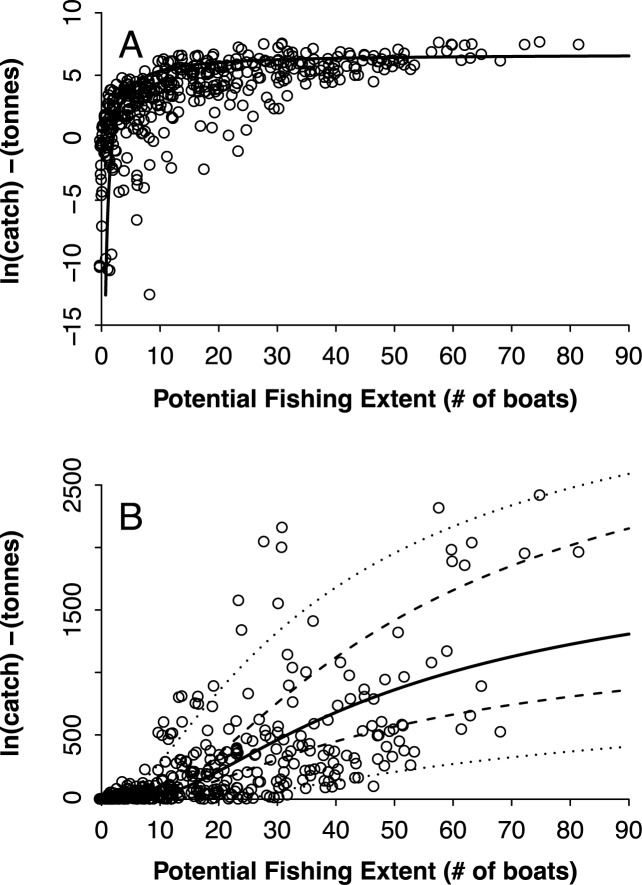
Relationship between Predicted Fishing Effort (# of boats per 500 km2) and mean total annual catch.In logarithmic form (A) and arithmetic form (B). Points represent raw data (one value per 500 km2 grid cell), solid lines are the fitted non-linear models, the dashed lines are the 95% prediction intervals of the fit, and the outer dotted lines show one standard deviation for the regression residuals. Note the funnel-shaped errors: as PFE increases so does dispersion in the data.